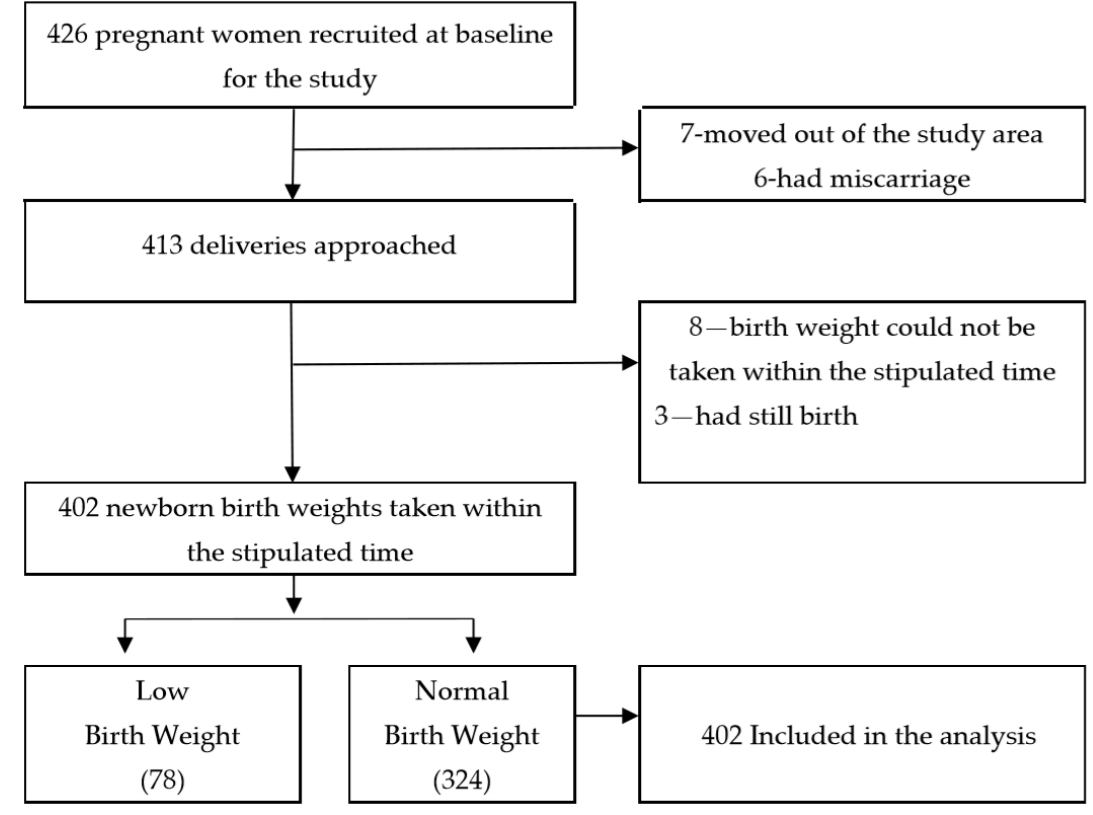
Figure 1. Flow chart showing the process of sample selection.